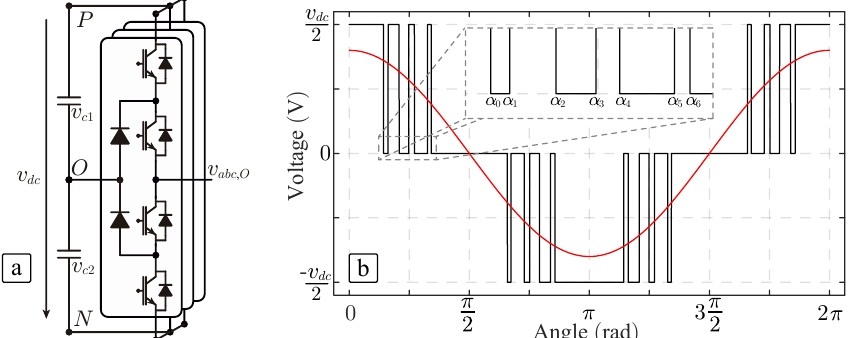
Figure 1. ( a ) General schematic for a three-level three-phase power convert. ( b ) Switching pattern example considering seven switching angles applied to a three-level power